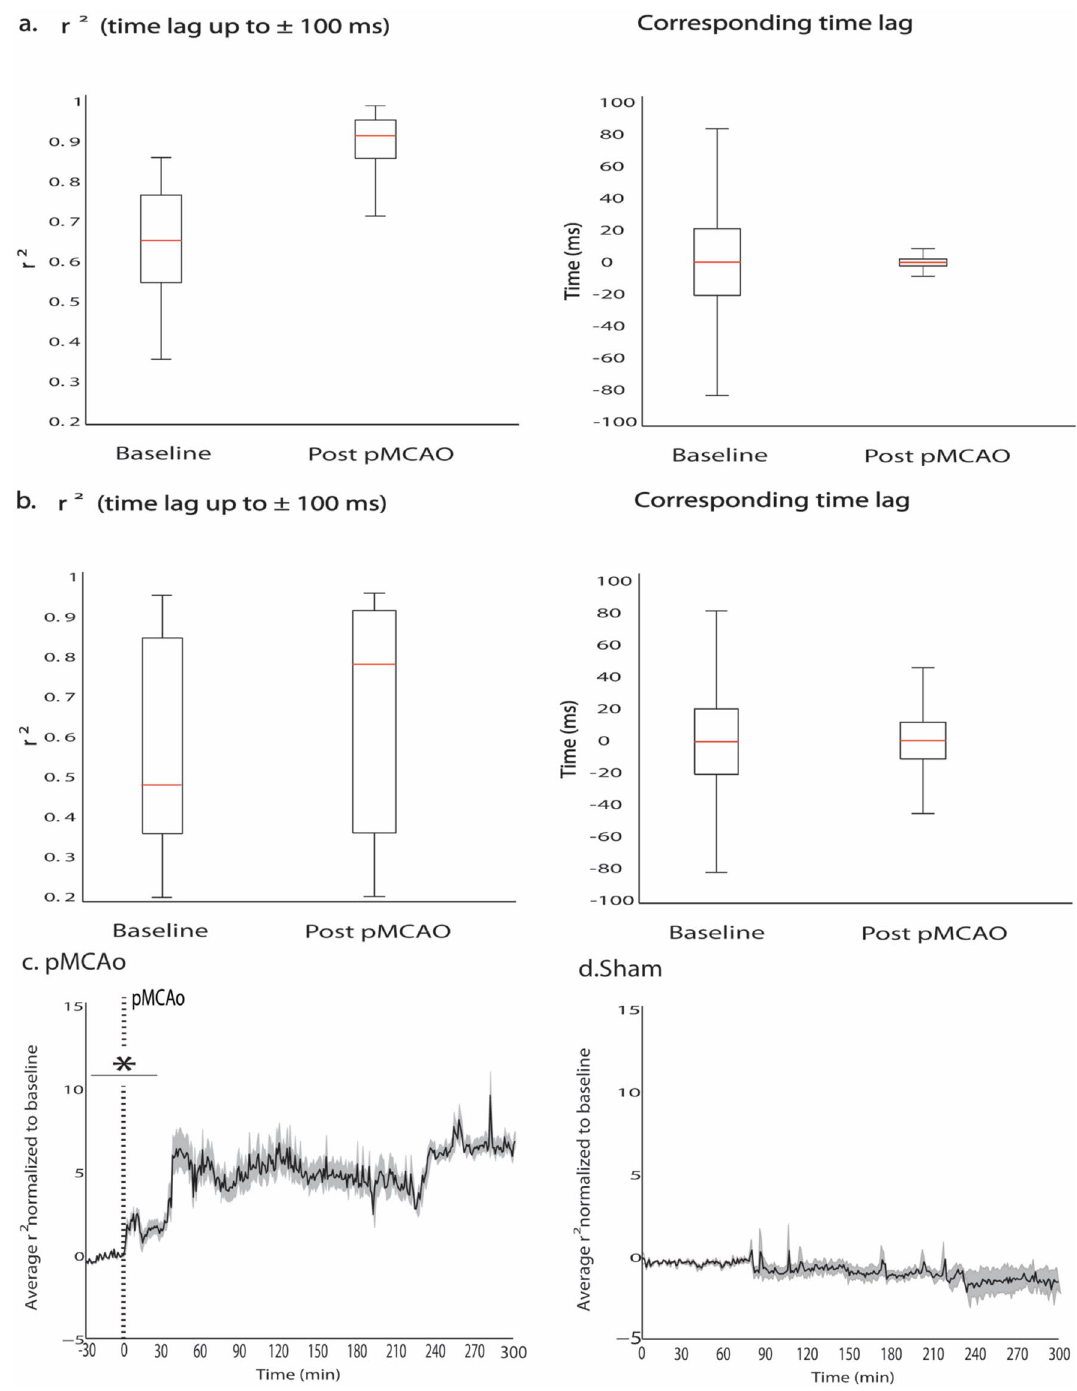
Figure 5. Cross-correlations were used to quantify the increase in spatiotemporal synchrony of spontaneous LFP occurring directly after pMCAo. ( a ) Box and whisker plots of the range of r 2 values and corresponding time lags in the 10 min before and 10 min directly after pMCAo in the representative case shown in Fig. 4. ( b ) Box and whisker plots of the range of r 2 values and corresponding time lags from all pMCAo animals ( n = 7) 10 min before and 10 min directly after pMCAo. The larger range of r 2 values represented in b as compared to a is likely related to between animal differences in spatiotemporal synchrony onset after pMCAo. ( c ) The average cross- correlation coefficient (baseline normalized) measure increased significantly after pMCAo and was persistently high throughout the acute post pMCAo period (group statistic, n = 7, 95% CI = 5.20, 5.47, Bootstrapped t-statistic comparison to null). ( d ) The average cross-correlation coefficient (baseline normalized) measure is consistent throughout 5 h of recordings in surgical sham animals (group statistic, n = 4, 95% CI = − 0.03, 0.02, Bootstrapped t-statistic comparison to null). Both ( c ) and ( d ) represent the average cross-coefficient measure in the solid black line and the standard error between animals in gray